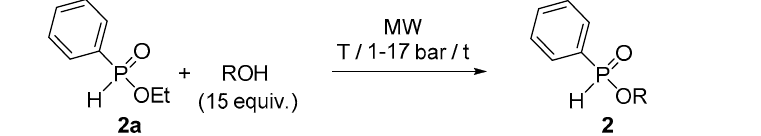
Table 3. Transesterification of ethyl-phenyl- H -phosphinate ( 2a ) in a batch MW reactor.